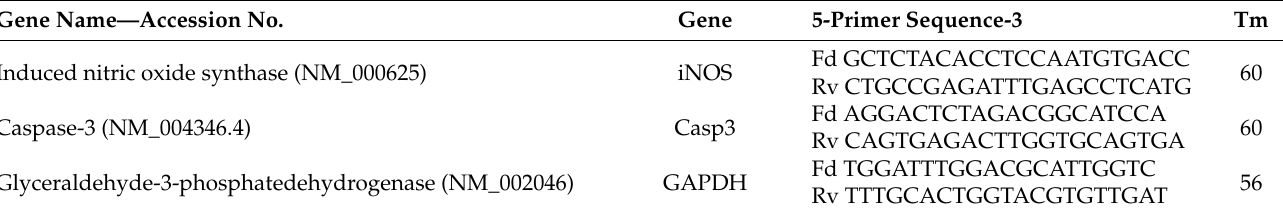
Table 1. PCR primers, genes, and reaction